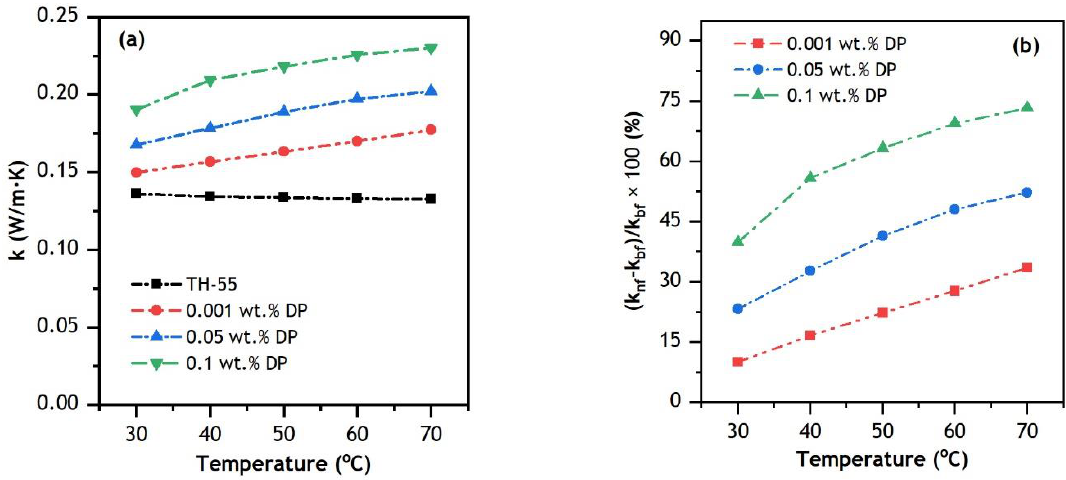
Figure 7. Thermal conductivity ( a ) variation and ( b ) enhancement of TH-55 and TH-55/DP NFs.